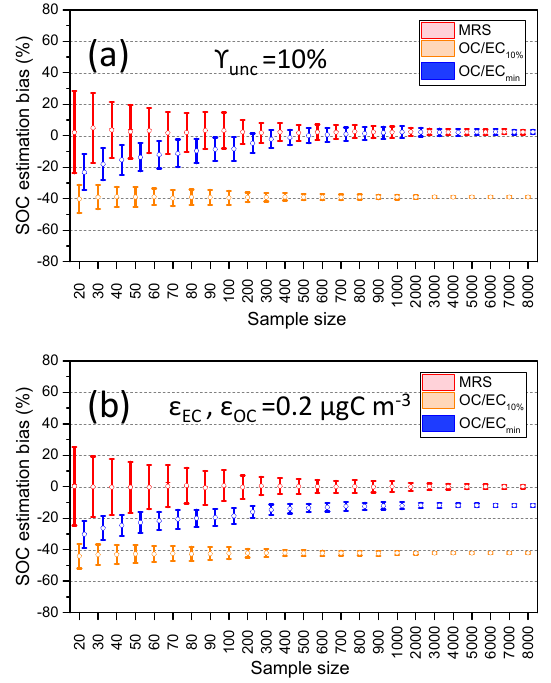
Figure 8. SOC estimation bias as a function of sample size by different approaches of estimating (OC / EC) pri , including mini- mum R squared (MRS), OC / EC 10 % , and OC / EC min , (a) as- suming a fixed relative measurement uncertainty of 10% for OC and EC; (b) assuming a fixed absolute measurement uncertainty for OC and EC (0.2µgm − 3 ) . For each sample size, 500 repeat runs were conducted. The empty circles represent mean of 500 repeat runs, the whiskers represent 1standard deviation. Parame- ters used for testing: repeat runs = 500, n = 20–8000, EC = 8 ± 4µgCm − 3 , (OC / EC) pri = 0.5, POC = 4 ± 2µgCm − 3 , f SOC = 40%, and SOC = 2 . 67 ± 1 . 33µgCm − 3